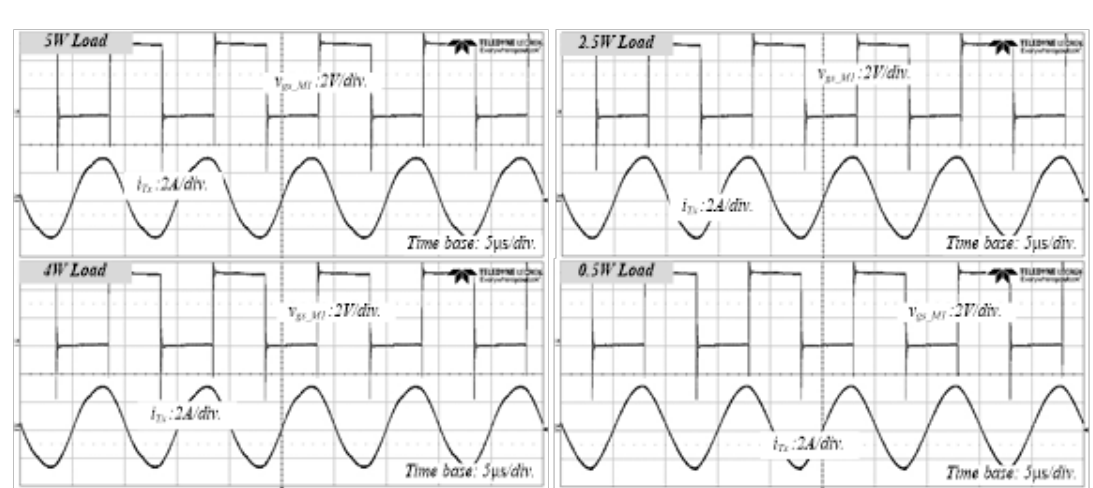
Figure 11. Experimental set.